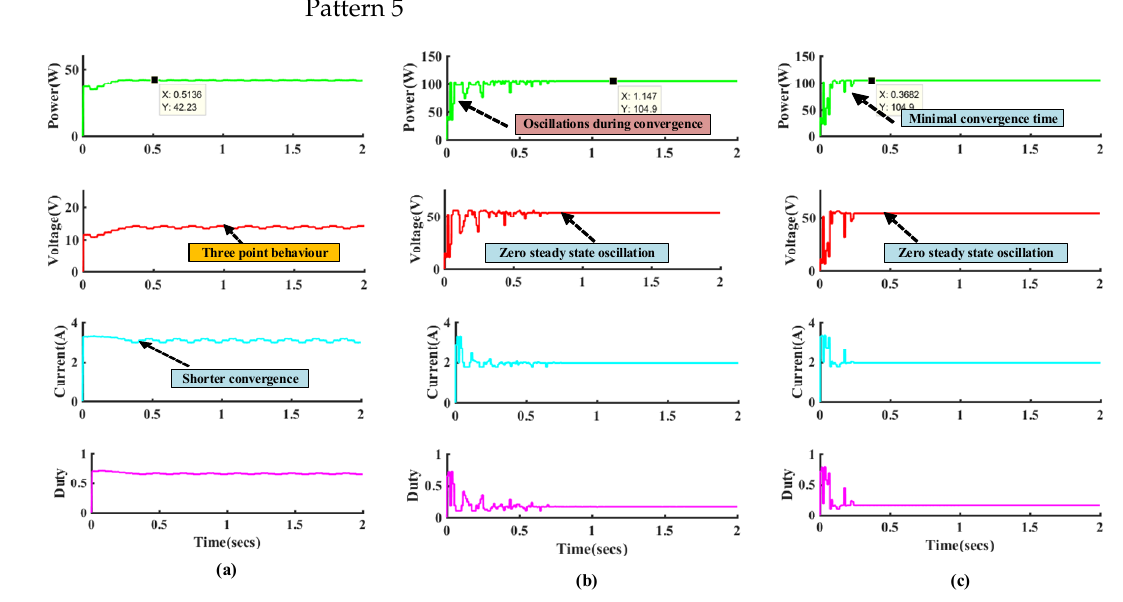
Figure 14. Simulated waveforms of ( a ) P& O, ( b ) PSO, and ( c ) SHO methods for Pattern 5.